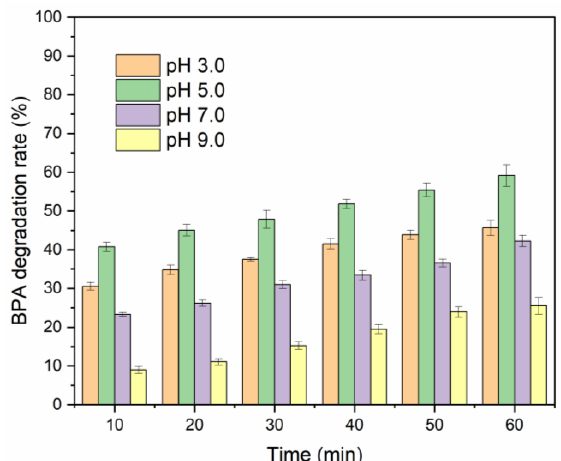
Figure 3. The effect of initial BPA concentration on BPA degradation. [PS] = 0.2 mM, [magnetite] = 0.1 g/L, T = 20 °C, pH = 7.0.